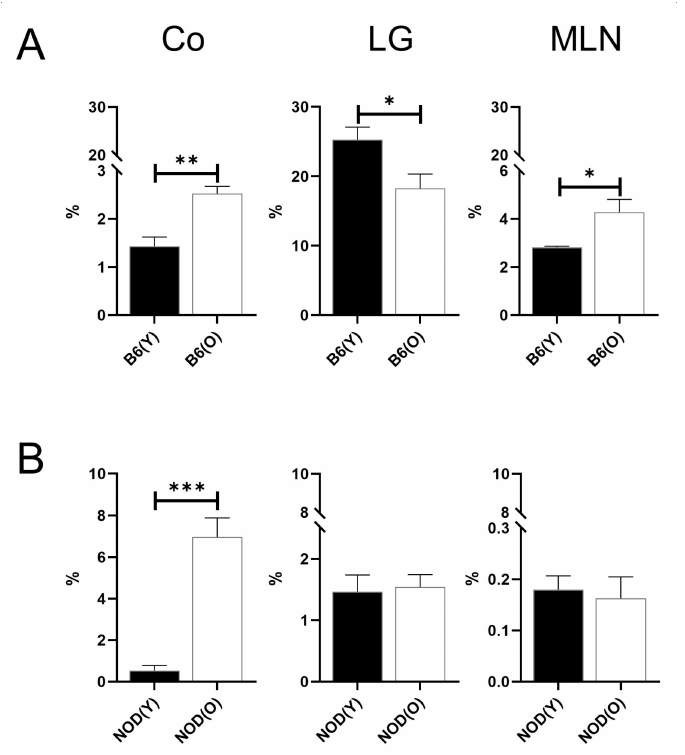
Figure 3. Distribution of CD11b + DCs in B6 ( A ) ( n = 4) and NOD.B10.H2 b ( B ) mice ( n = 4). The total number of CD45 + cells was used as the denominator to compensate for the actual fraction of each subset in corneolimbus and LG. In MLN, the percentage of subsets was calculated as the percentage within total cells. The percentage of CD11b + DCs was higher in corneolimbus and MLN of aged B6 mice ( p = 0.004, p = 0.035, respectively). However, CD11b + DCs of LG were significantly lower than in young B6 mice ( p = 0.044). The percentage of corneolimbal CD11b + DCs in aged NOD.B10.H2 b mice was significantly higher than in young NOD.B10.H2 b mice ( p < 0.001). All experiment results were tested for statistical differences using unpaired, two-tailed independent t-tests. Data are expressed as the mean ± standard error of the mean. B6, C57BL/6; NOD, NOD.B10.H2 b ; DC, dendritic